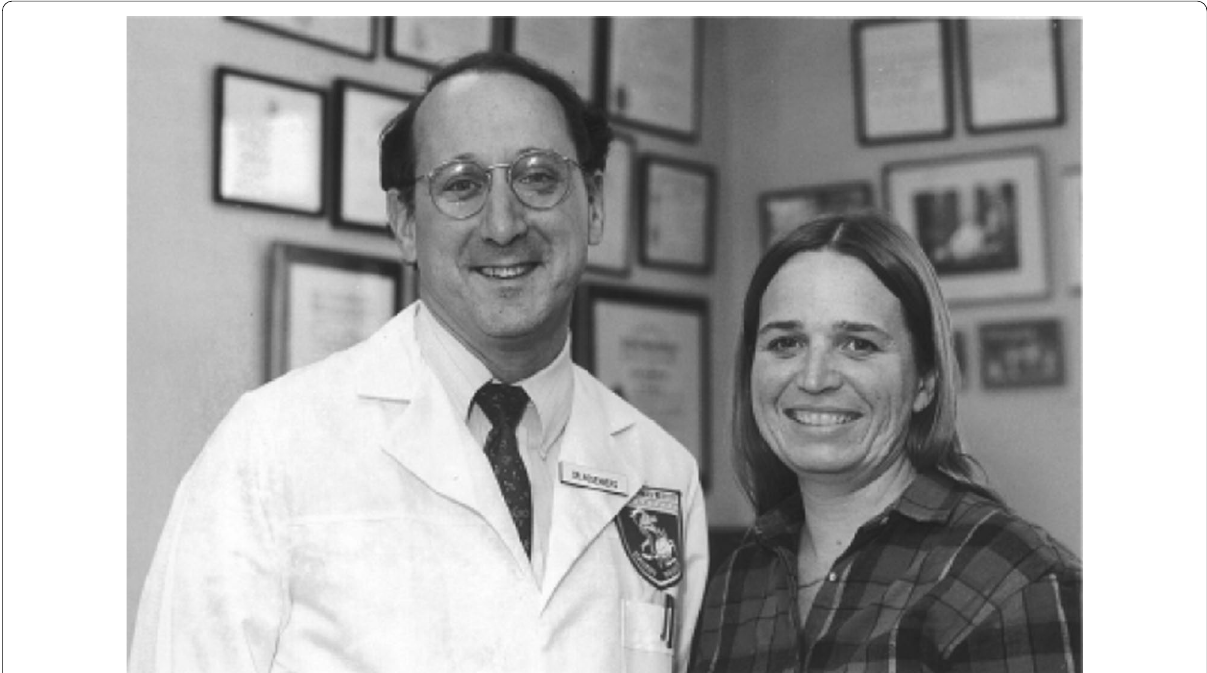
Fig. 1 With the first patient to respond to IL-2 administration. Her metastatic melanoma underwent a complete regression in 1984 and she remains disease-free over 36 years